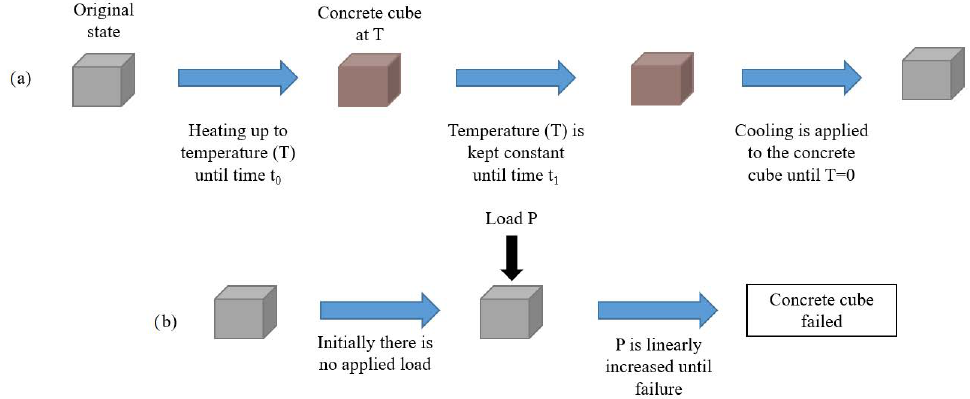
Figure 2. ( a ) Heating and ( b ) loading schemes of the unstressed condition.